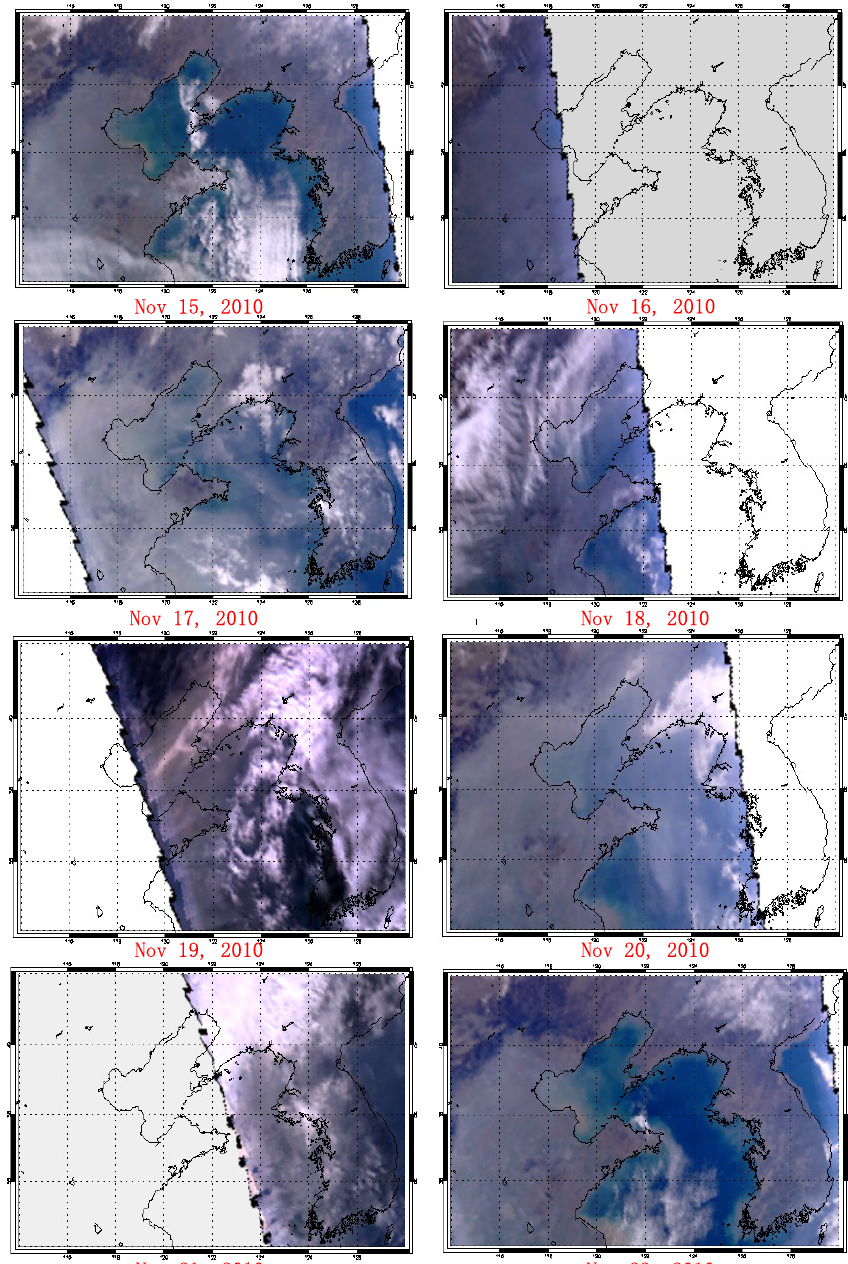
Fig.10 RGB images (0.44, 0.565, 0.675  m) over East Asia captured by POLDER during December Fig. 10. RGB images (0.44, 0.565, 0.675µm) over East Asia captured by POLDER during 15–22 December 15-22, 2010.